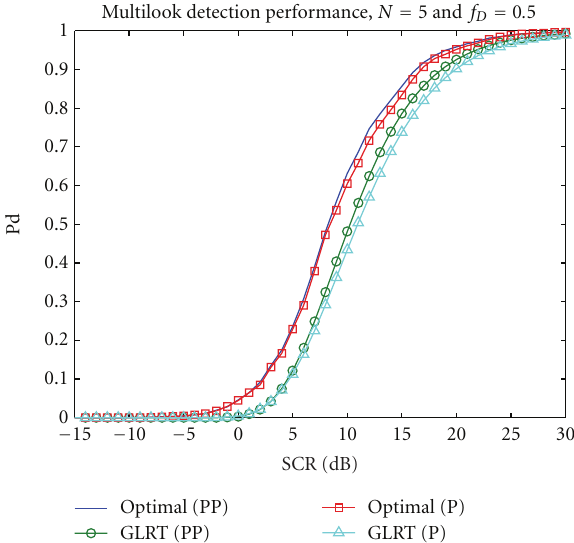
Figure 5: A second example of detector performance, with same legend as for Figure 1. In this case, the clutter strength has been increased (Toeplitz factor of 0.7) and the number of looks decreased. As in the previous figure, the detection gain provided by a mixture model is very small.